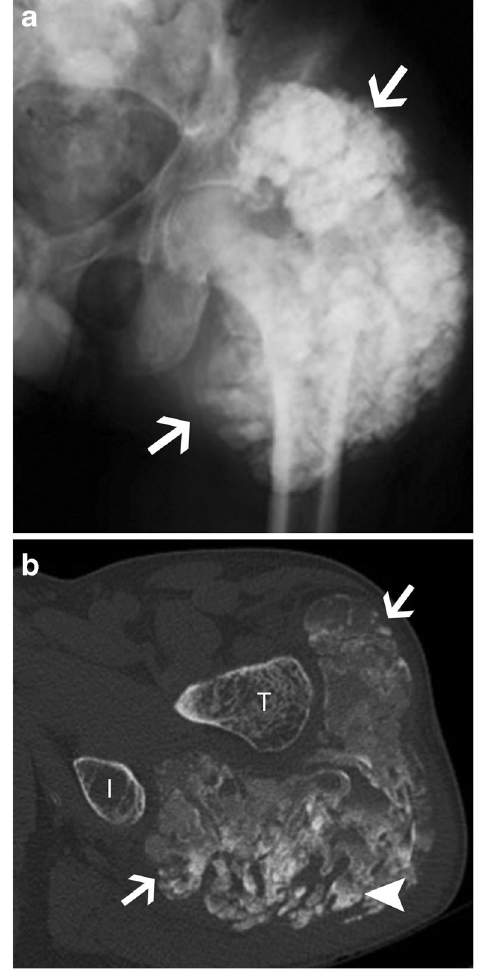
Fig. 18 Renal insufficiency with tumoural calcinosis. ( a ) Anteroposterior radiograph of the pelvis and ( b ) axial CT image of the left hip show tumoural calcinosis (arrow) around the left hip with a multiloculated appearance in a clinical context of chronic renal failure. Note fluid-fluid level with denser material layering more posteriorly (arrowhead in b). I: ischium, T: greater trochanter